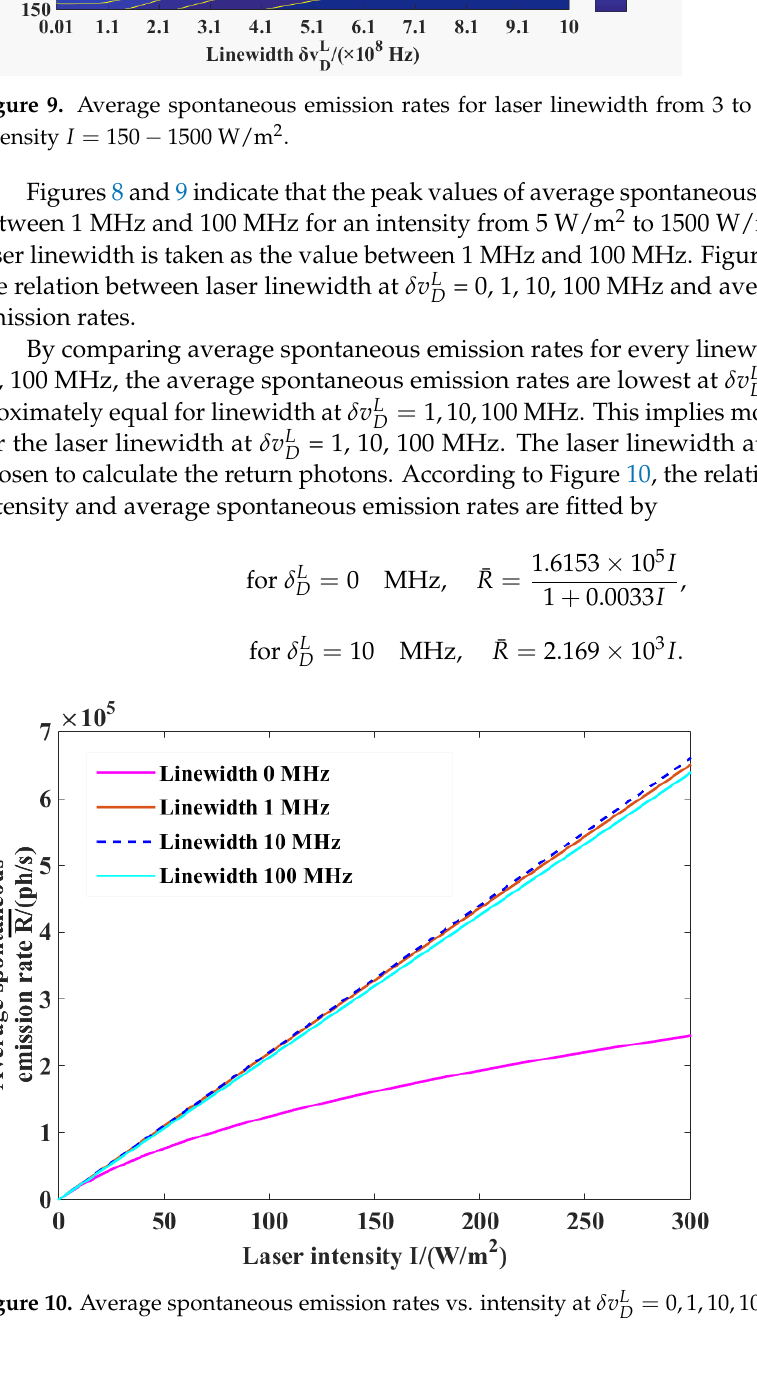
Figure 10. Average spontaneous emission rates vs. intensity at δ v L